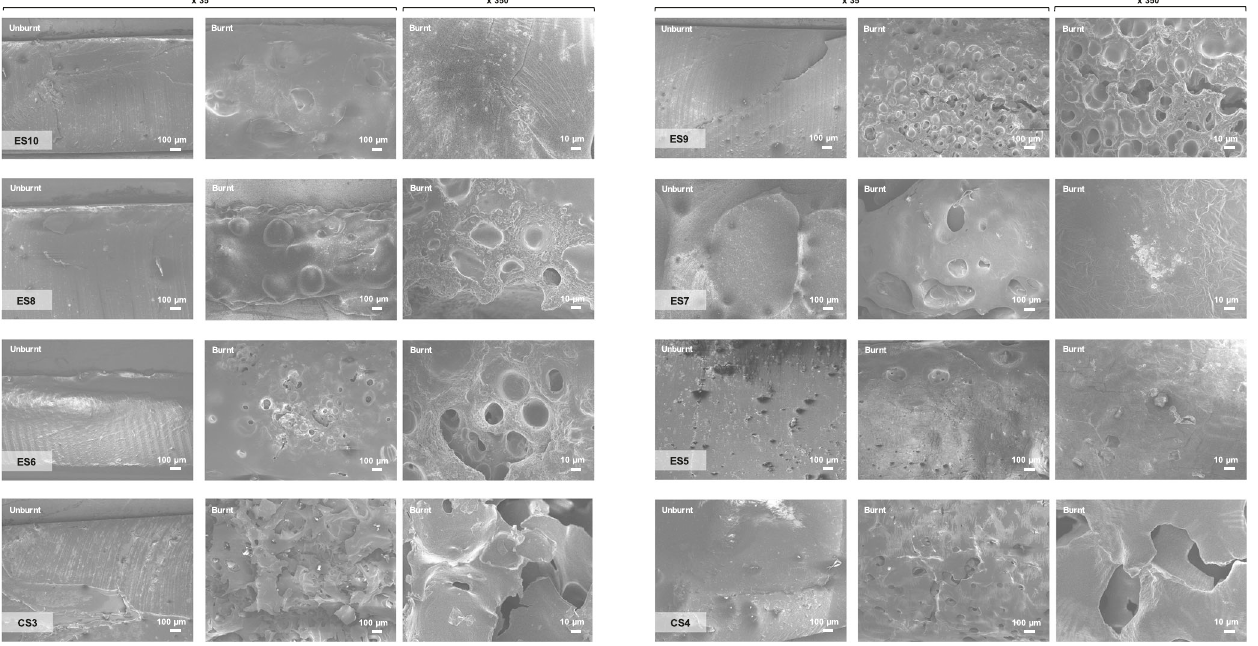
Fig. 6 SEM micrographs of the cross-section of the unburnt and burnt polyurea in fl ammability tests. Left : AR3 series with aromatic diamine only. Right : AR4 series with both aromatic diamine and aromatic